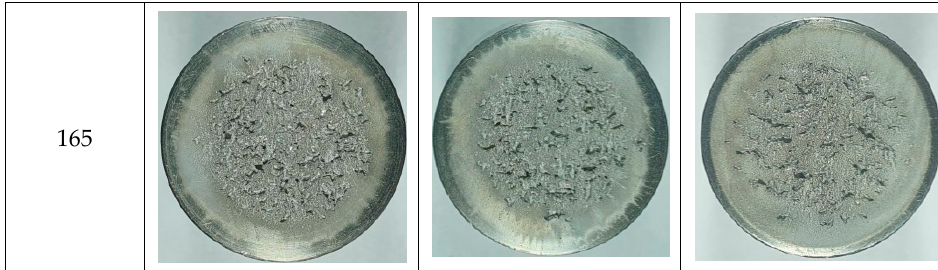
Figure 9. Macrographic images of the surface in cavitation tests of variable durations.